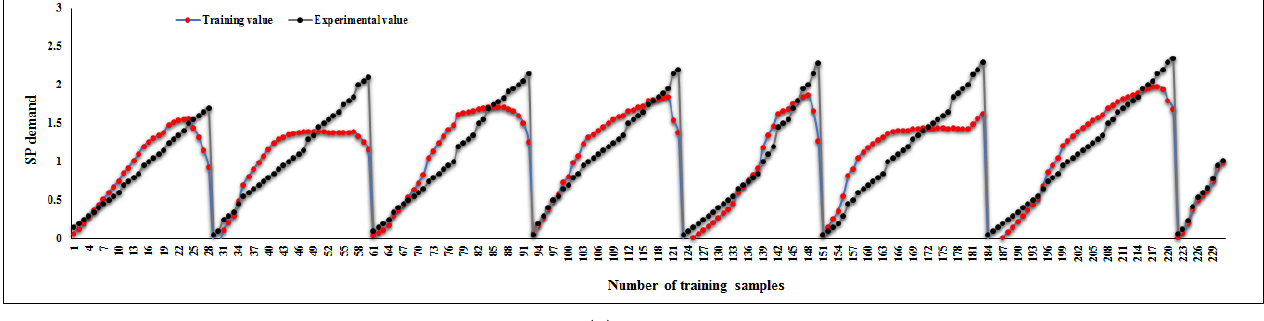
Figure 16. Tolerance diagram of predicted and measured values for ( a ) training phase and ( b ) testing phase.